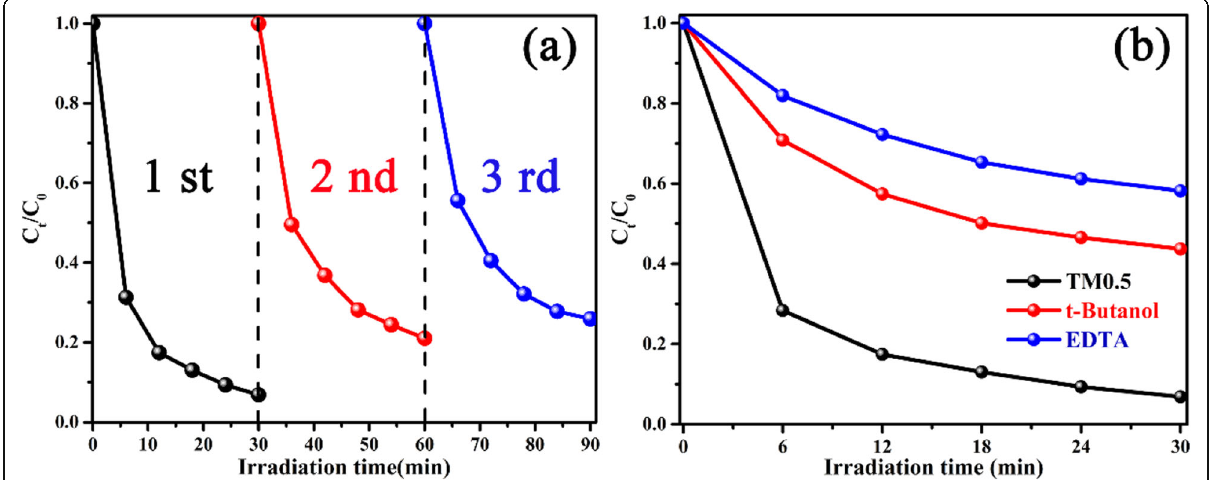
Fig. 7 a Recycling photocatalytic experiments of TM0.5 sample for photocatalytic degradation of MO by repeating three times under same condition. b Effects of different scavengers on the MO photodegradation process under visible light